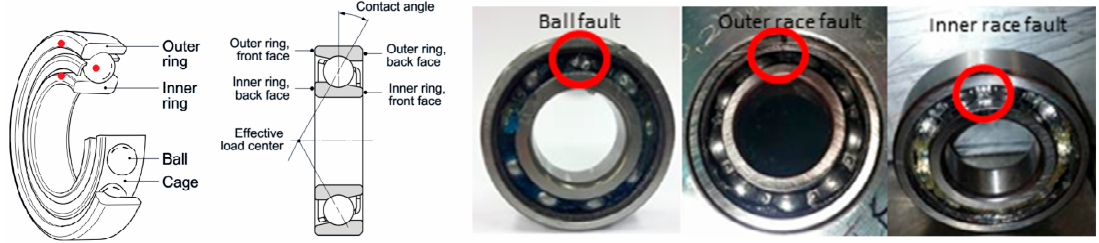
Figure 4. Bearing Structures and Fault Location Sketch Map.